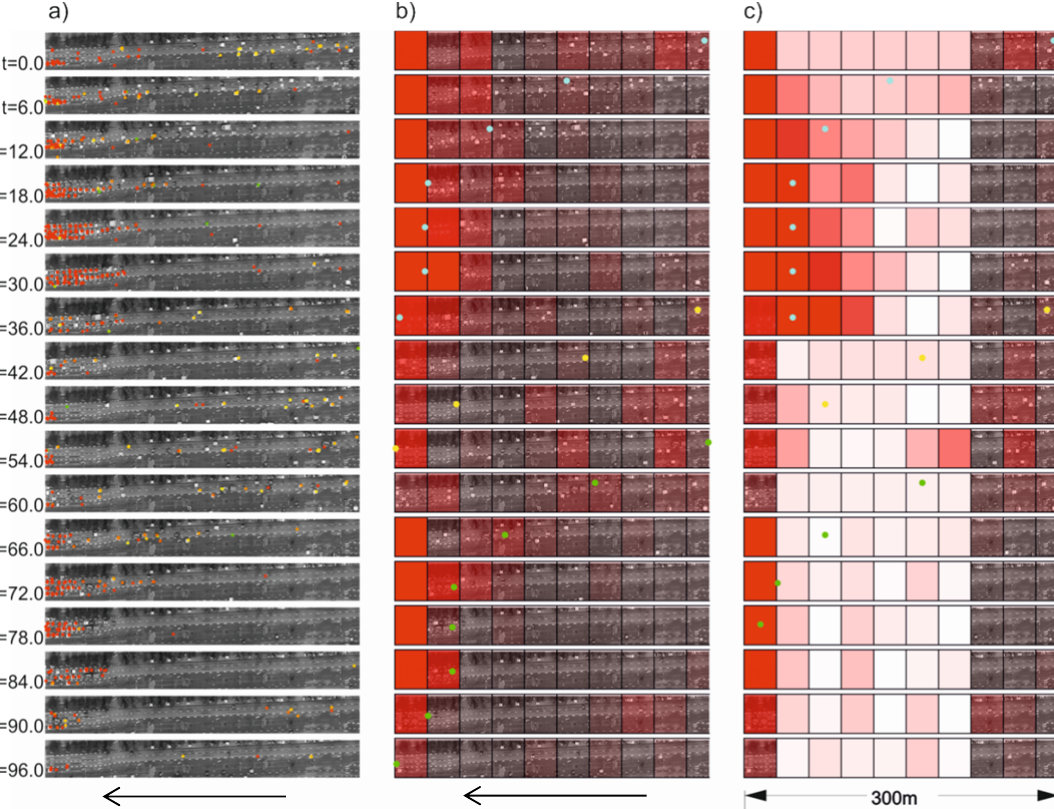
Figure 4: 4k image sequences showing the traffic flow from right to left a) the results of the automatic vehicle detection and tracking; b) the calculated traffic density and real travel times of three reference vehicles (cyan, yellow, green dots); c) the results of the traffic density and travel time estimation to bypass a simulated tracking outage for the three reference vehicles based on the CTM